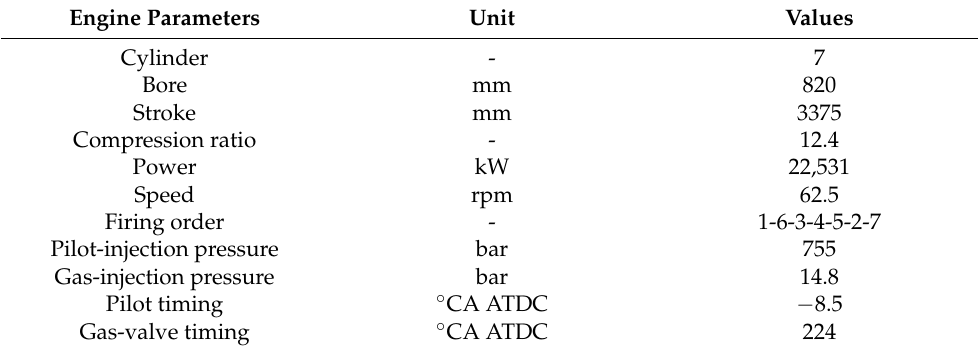
Table 1. Dual-fuel engine main parameters. Engine Parameters Unit Values